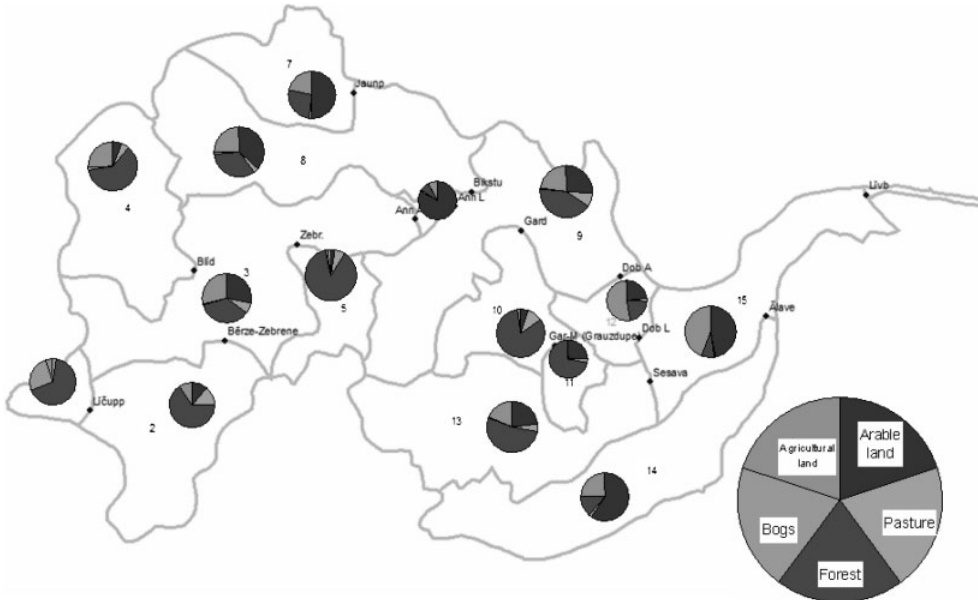
Fig. 11. P tot diffuse source apportionment in Be¯rze River subcatchments (2000 (cid:2)